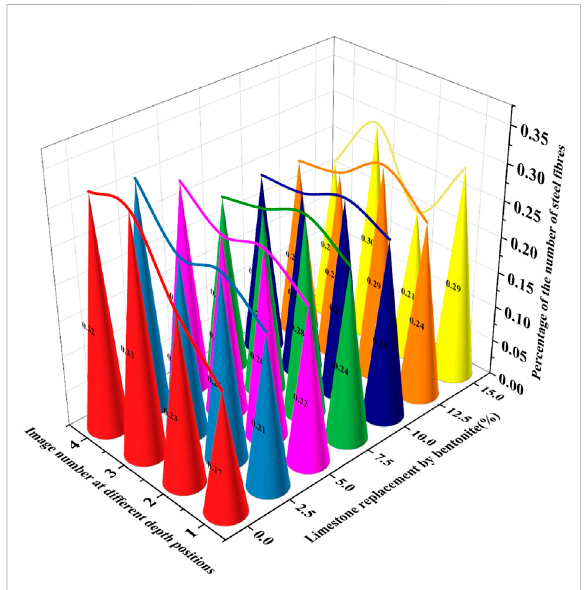
FIGURE 11 Variation of steel fi bre content on different depth positions.